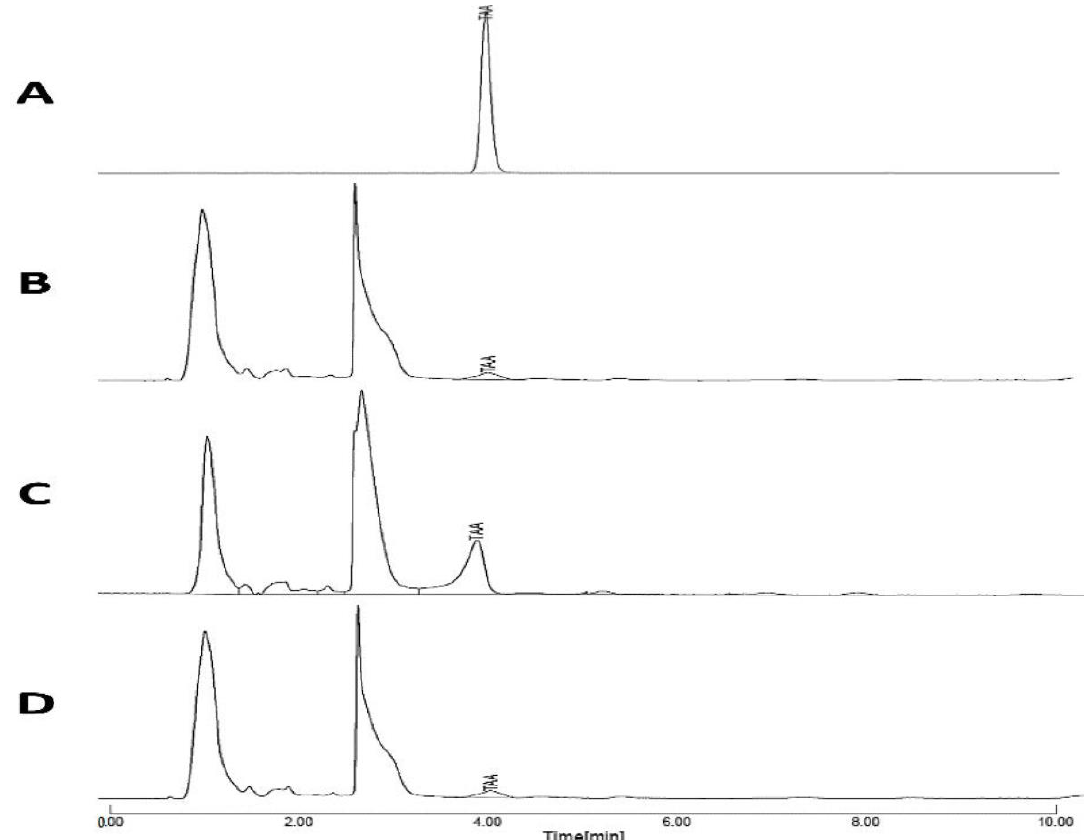
Figure 9. HPLC Chromatograms of ( A ) standard TAA in mobile phase, ( B ) sample of plasma concen- tration determination, PC, ( C ) sample of lung fluid concentration determination, FC, ( D ) sample of lung tissue determination,